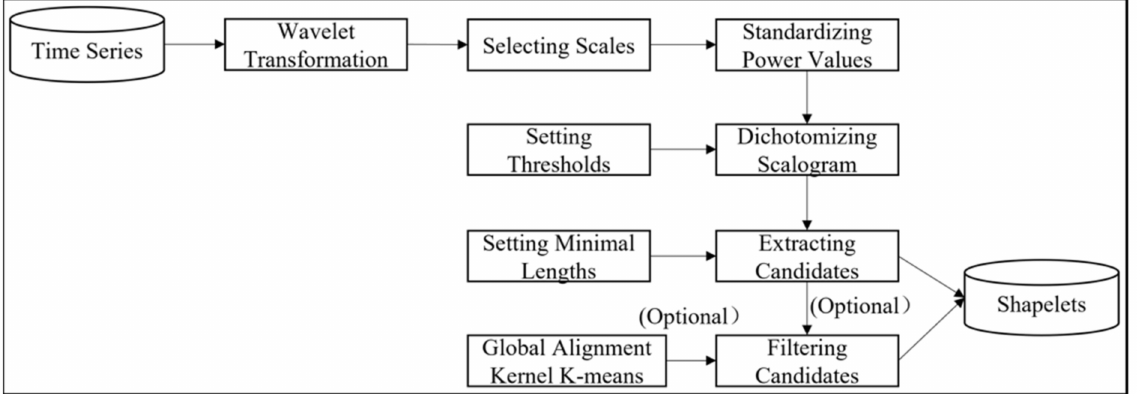
Figure 4. Workflow chart of applying W-TSS to select